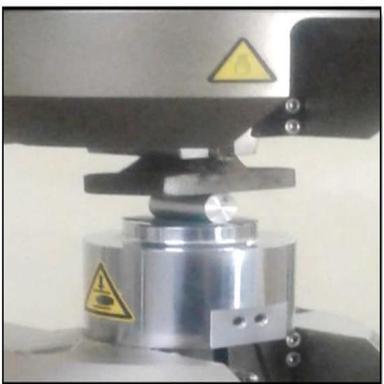
Compression on 31% sample.